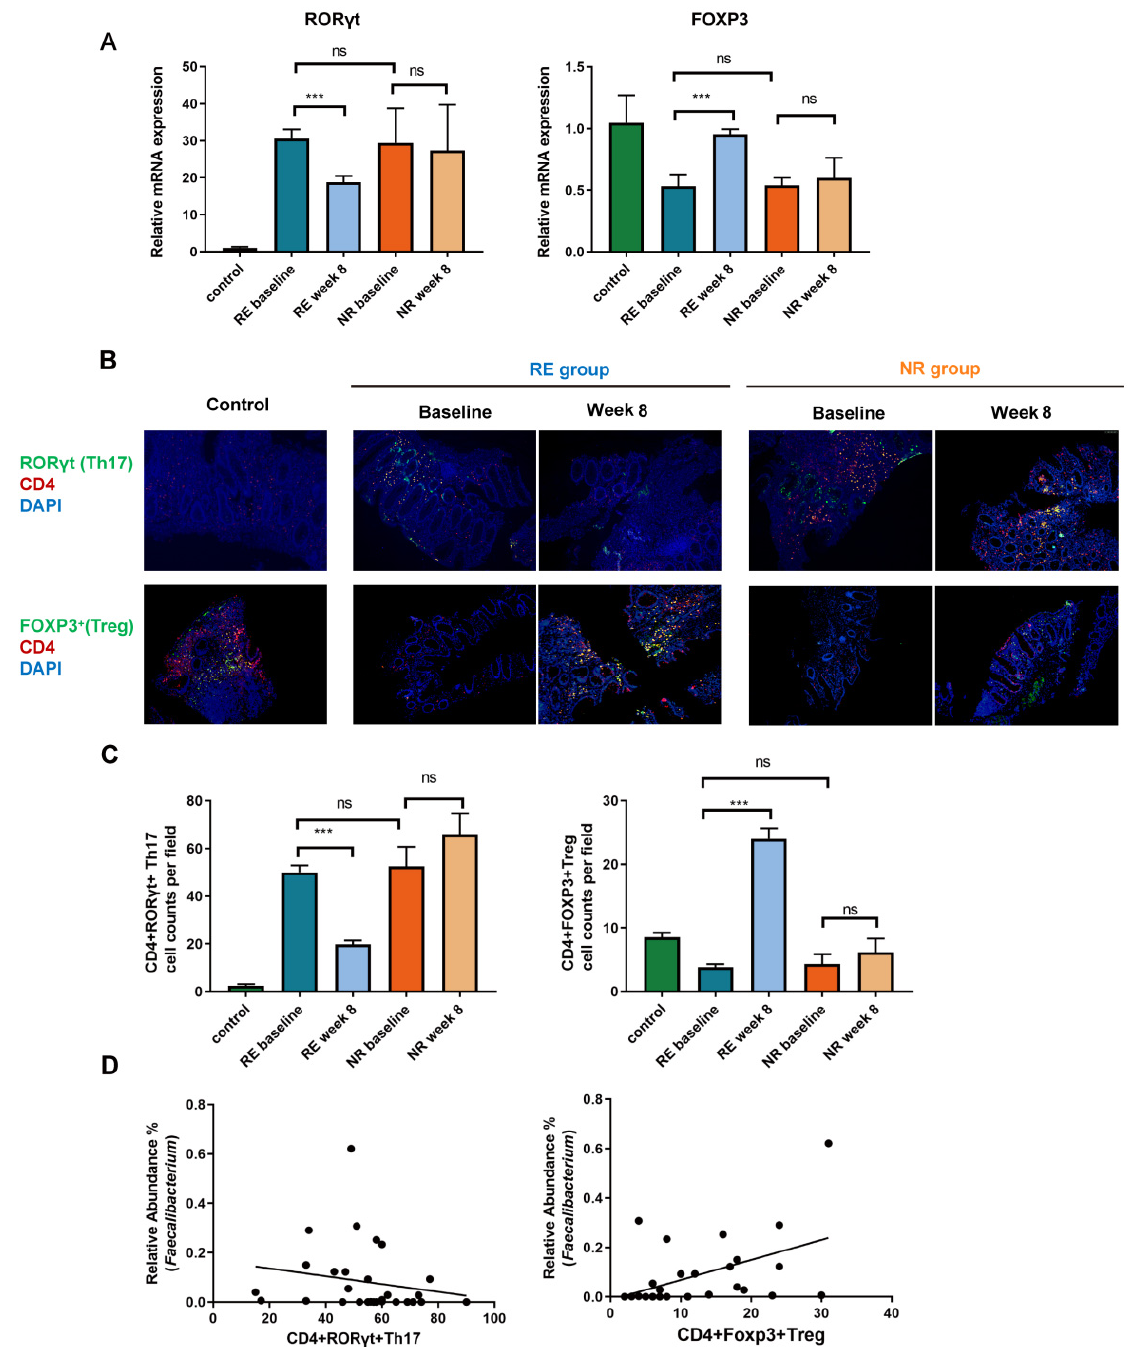
Figure 6. Faecalibacterium alleviates intestinal inflammation by regulating intestinal Th17/Treg imbalance. ( A ) The relative mRNA expression of ROR γ t and Foxp3 in colon. ( B ) Double immunofluo- rescence labeling was used to assess the colonic CD4+ ROR γ t+ Th17 and CD4+ Foxp3+ Treg cells. ( C ) The number of CD4+ ROR γ t+ Th17 and CD4+ Foxp3+ Treg cells per field of view was quantified, respectively (100× magnification). Each bar represents mean ± SEM. One-way ANOVA followed by Student–Newman–Keuls test was used for multiple-group comparisons. (ns > 0.05, *** p < 0.001). ( D ) Correlation of relative abundance of Faecalibacterium with CD4+ ROR γ t+ Th17 (r = − 0.430, p = 0.018) and CD4+ Foxp3+ Treg (r = 0.571, p = 0.001). (RE, responders; NR, non-responders).